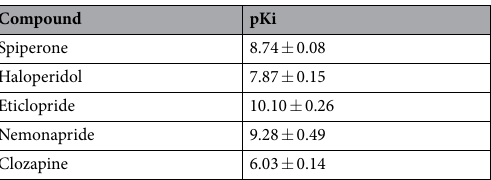
Table 1. Affinity of selective antagonists at hD 3 R-mEGFP. Values were calculated based on the ability of each ligand to compete with [ 3 H]spiperone to bind hD 3